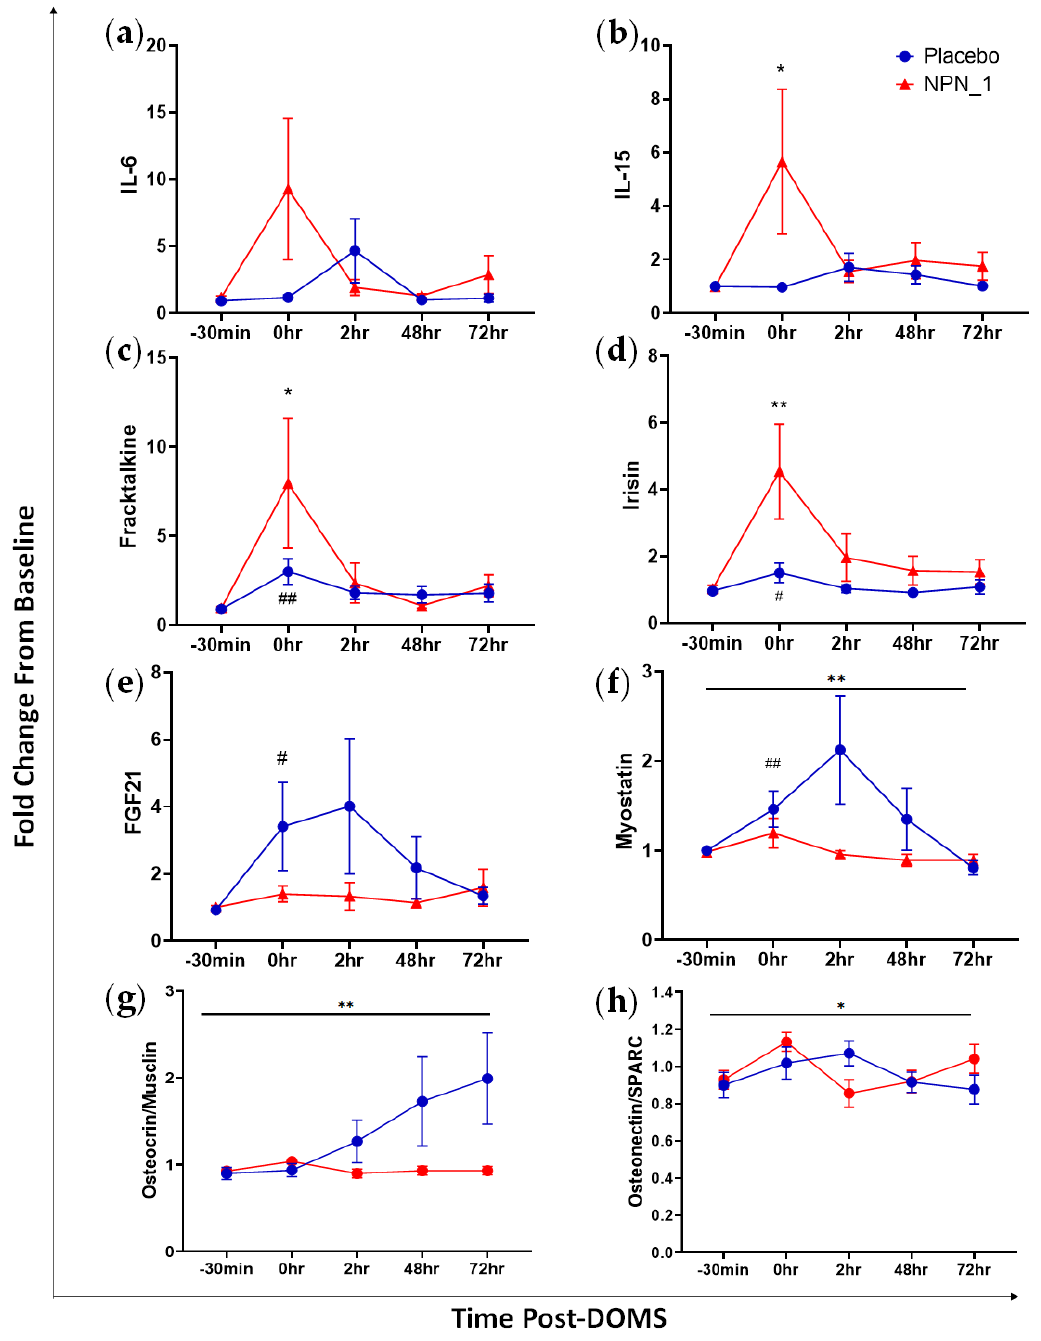
Figure 5. NPN_1 supplementation alters plasma myokine concentrations, increasing myokines associated with glycogenesis and protein synthesis, whilst decreasing those associated with negative regulation of protein synthesis. Serum myokine expression following intense exercise is altered with supplementation with NPN_1. Analysed by repeated measures ANOVA. ( a ) Effect of supplementation on IL-6 (mean ± SEM, RM-ANOVA, treatment effect: p = 0.138). ( b ) IL-15 (mean ± SEM, RM-ANOVA, treatment effect: p = 0.159, NPN_1 change from baseline, p = 0.045). ( c ) Fractalkine (mean ± SEM, RM-ANOVA, treatment effect: p = 0.351, NPN_1 change from baseline, p = 0.030, Placebo change from baseline, p = 0.003). ( d ) Irisin (mean ± SEM, RM-ANOVA, treatment effect: p = 0.096, NPN_1 change from baseline, p = 0.009, Placebo change from baseline, p = 0.031). ( e ) FGF21 (mean ± SEM, RM-ANOVA, treatment effect: p = 0.0662, Placebo change from baseline, p =